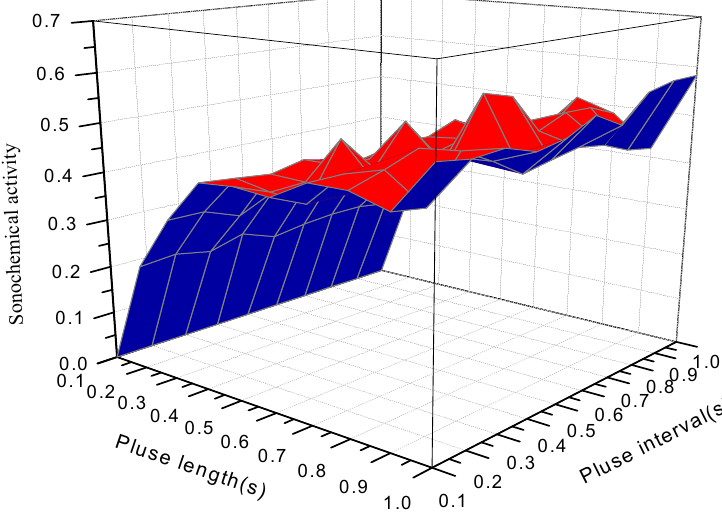
Figure 1. Influence of pulse length (0.1–1 s) and pulse interval (0.1–1 s) on the sonochemical activity.